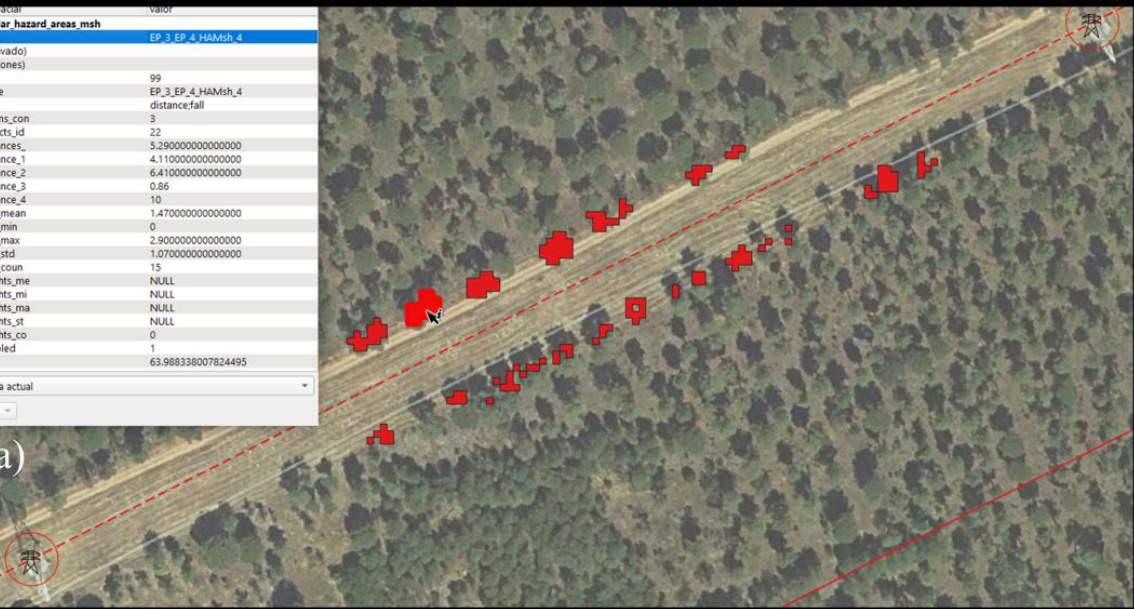
Figure 11. Comparison of risk areas obtained for the three processing types: ( a ) Public airborne Li- DAR data with theoretical catenary; ( b ) drone LiDAR data with theoretical catenary; and ( c ) drone LiDAR data with real catenary.